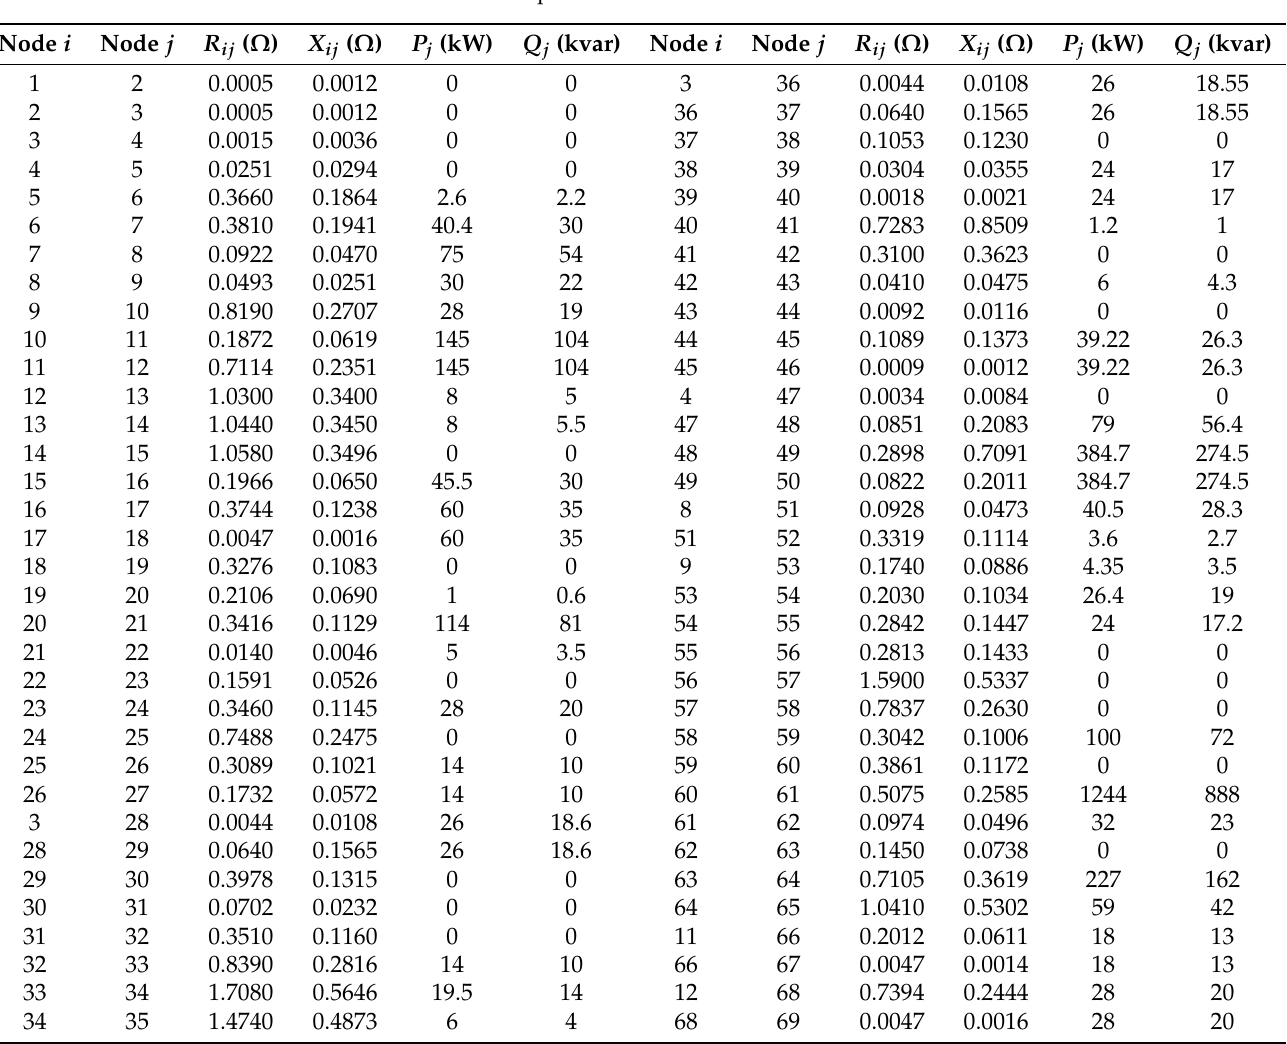
Table 3. Electrical parameters of the 69-node test feeder.